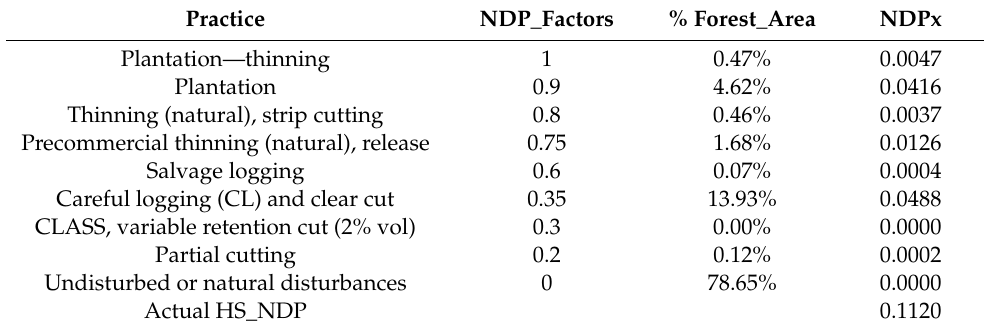
Table 4. Naturalness degradation potential (NDP) for horizontal structure (HS) by silvicultural treatments in Quebec’s boreal forest.